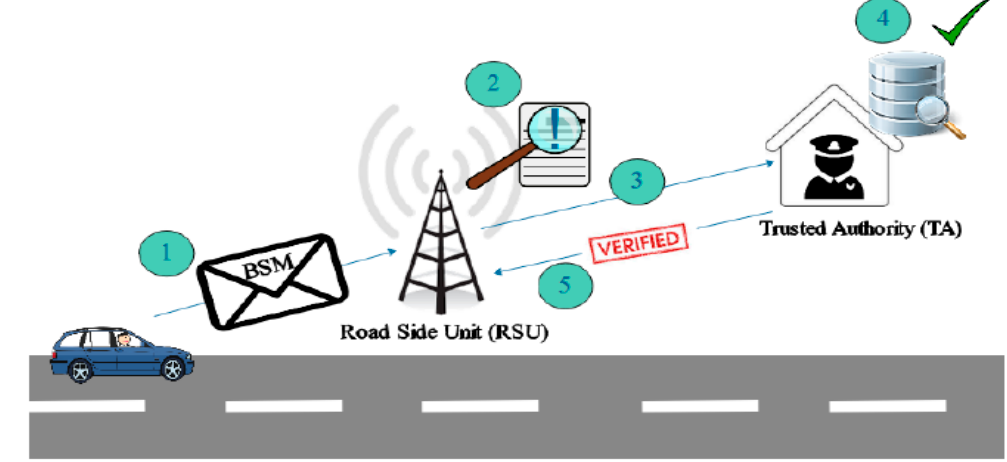
Figure 5. Scenario 1 illustration.